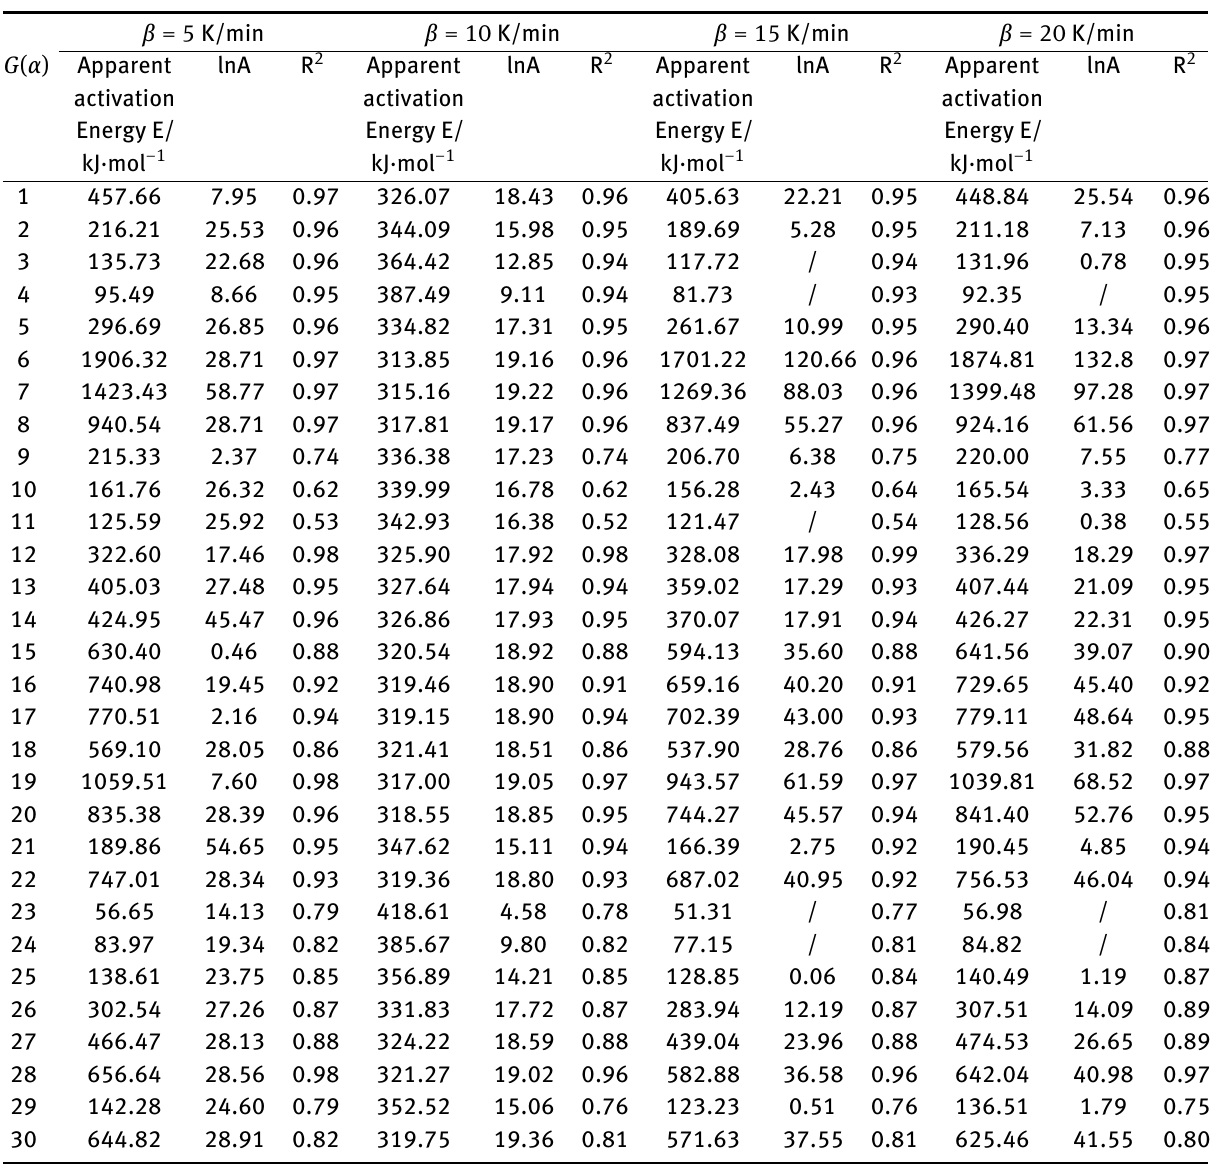
Table 4: Calculating results of CR method on kinetic parameters of carbothermal reduction of phosphate rock with particle size 48–75 µ